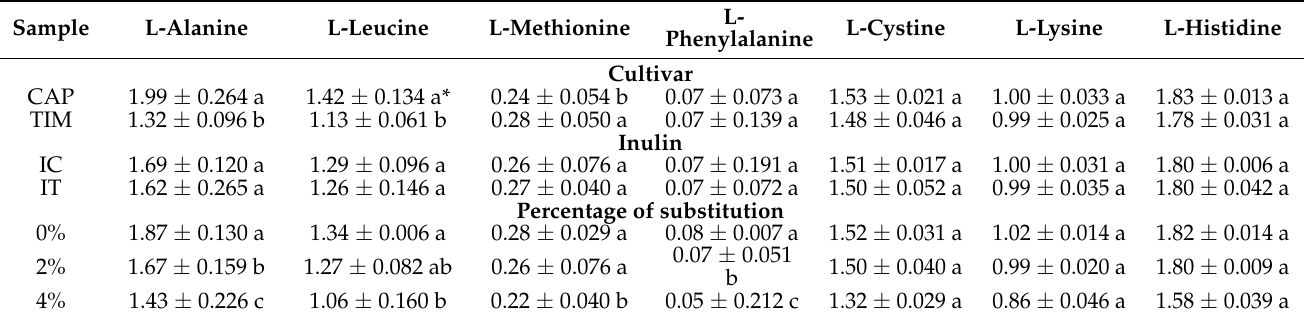
Table 7. Aminoacid content (g/100 g of spaghetti-mean ± SD, n = 3) as affected by cultivar, inulin- type, and percentage of